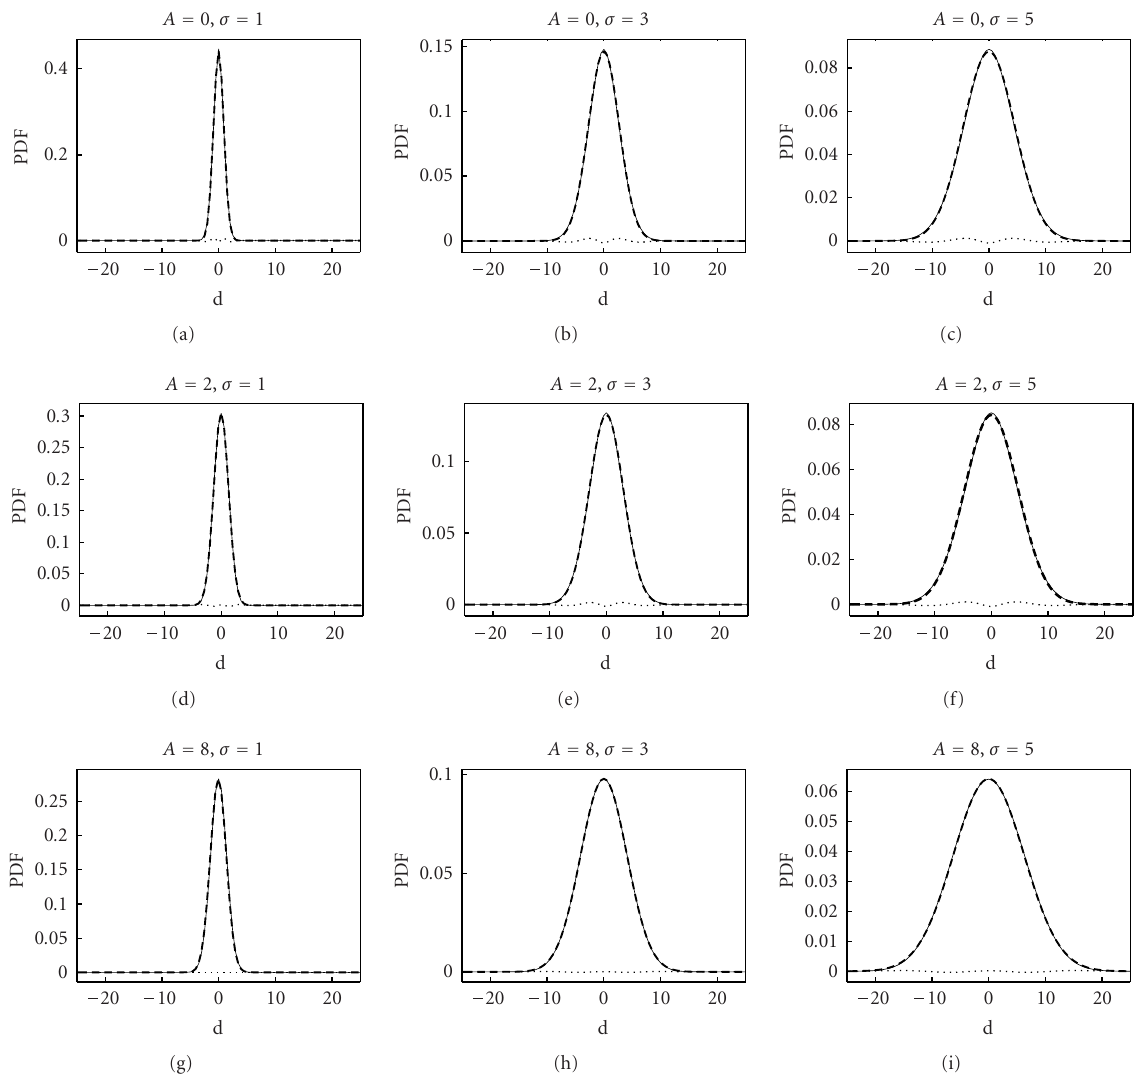
Figure 2: The exact null distribution C A , σ ( s ) (solid), the fitted Gaussian (dashed), and the di ff erence between C A , σ ( s ) and the Gaussian (dotted). Note that the fitted Gaussian is hardly distinguishable from the exact